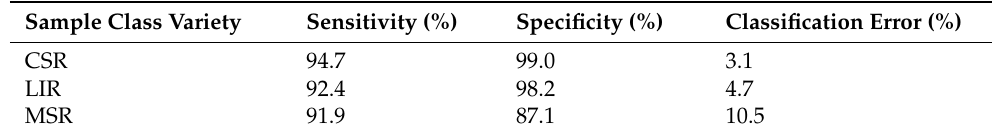
Table 2. Multiclass predictions by cross-validation for the analyzed honey samples according to their geographical climatic production region using two LVs. CSR: Cantabrian Sea region; LIR: landlocked inland region; and MSR: Mediterranean Sea region.